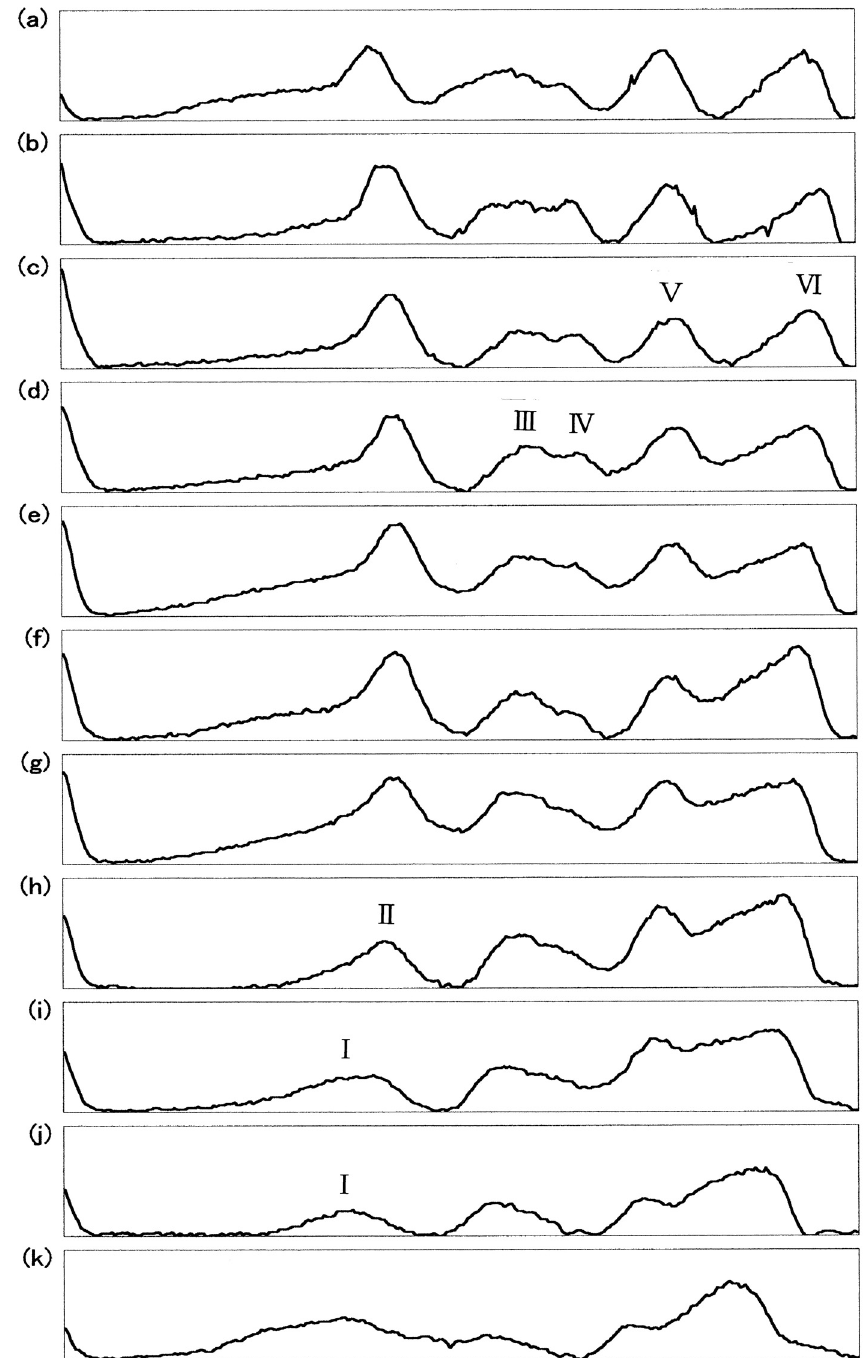
Figure 9. Densitometric profiles resulting from polyacrylamide gel electrophoresis by use of an image scanner. Each curve corresponds to the relevant column shown in Figure